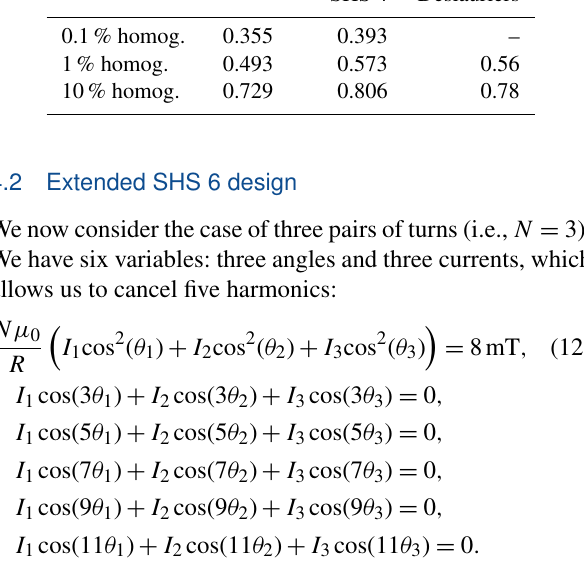
Table 3. Four-turn axisymmetric coil homogeneity: comparison be- Table 4. Six-turn axisymmetric coil homogeneity: comparison be- tween the four-turn SHS coils, the four-turn extended SHS and the tween the six-turn SHS coils and the six-turn extended SHS. four-turn Hoult and Deslauriers coil. SHS 4 Extended Hoult– SHS 4 Deslauriers 0.1% homog. 0.355 0.393 0.493 0.573 0.56 0.729 0.806 0.78